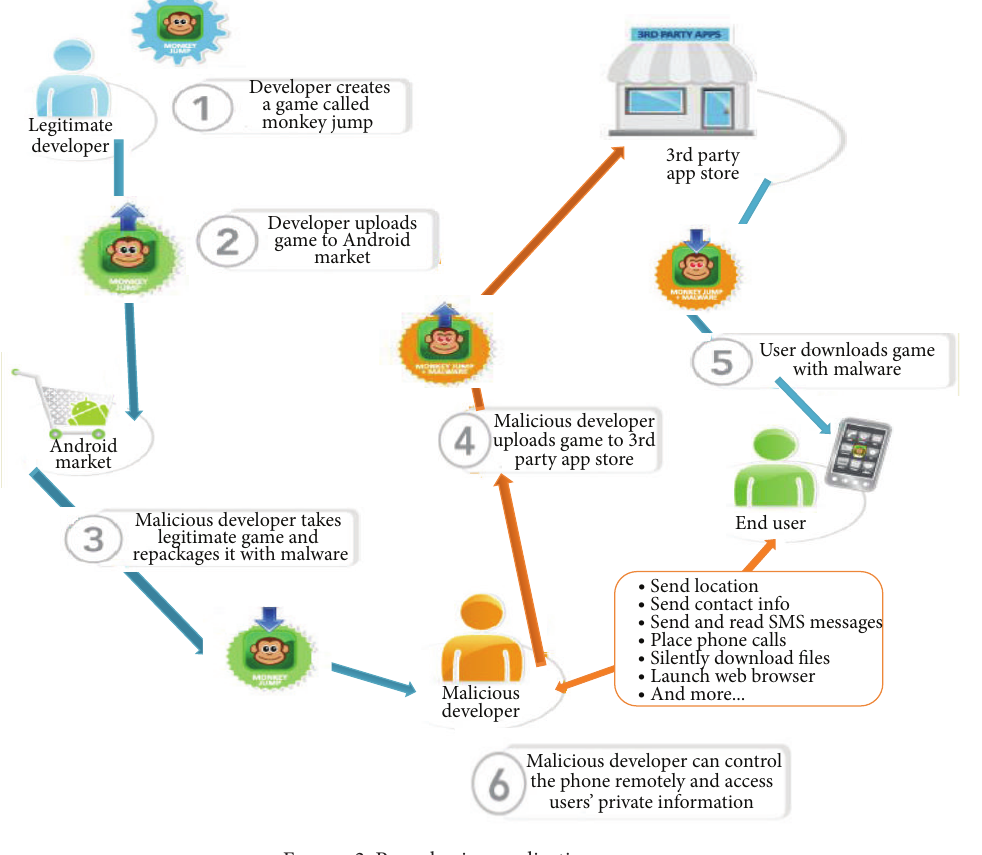
Figure 2: Repackaging applications process.